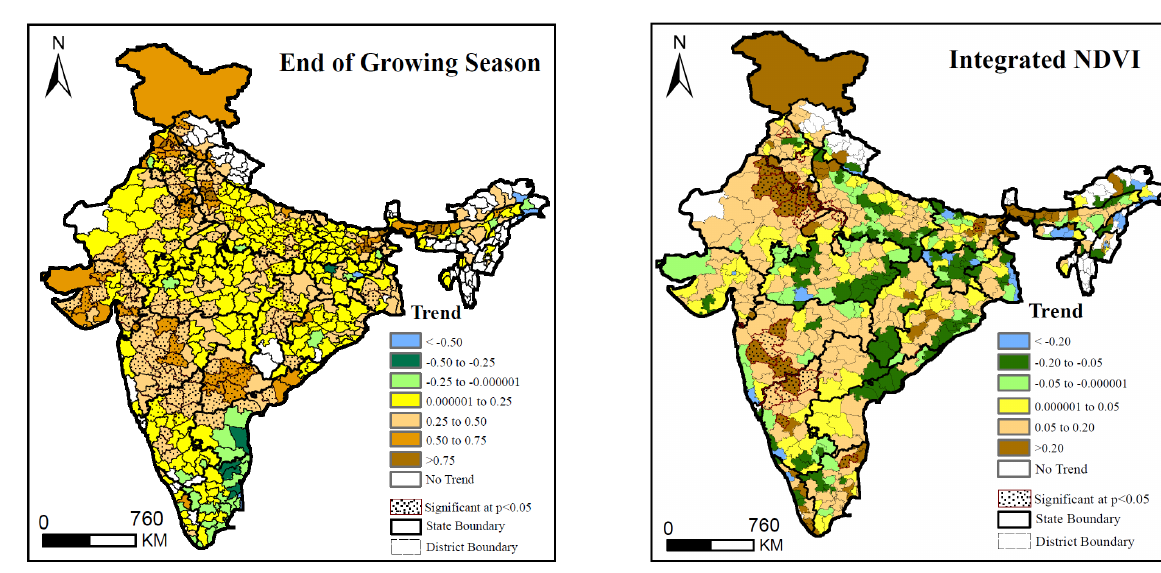
Figure 12 Trends of integrated NDVI for Kharif crop during 1982-2015. Figure 10 Trends of end of growing period for Kharif crop during 1982- 2015.